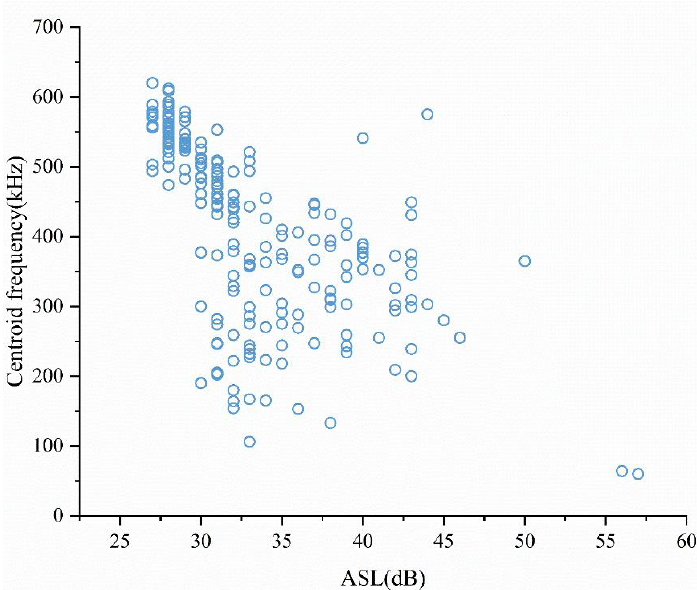
Figure 25. ASL-centroid frequency correlation diagram of Yangma Island Bridge.